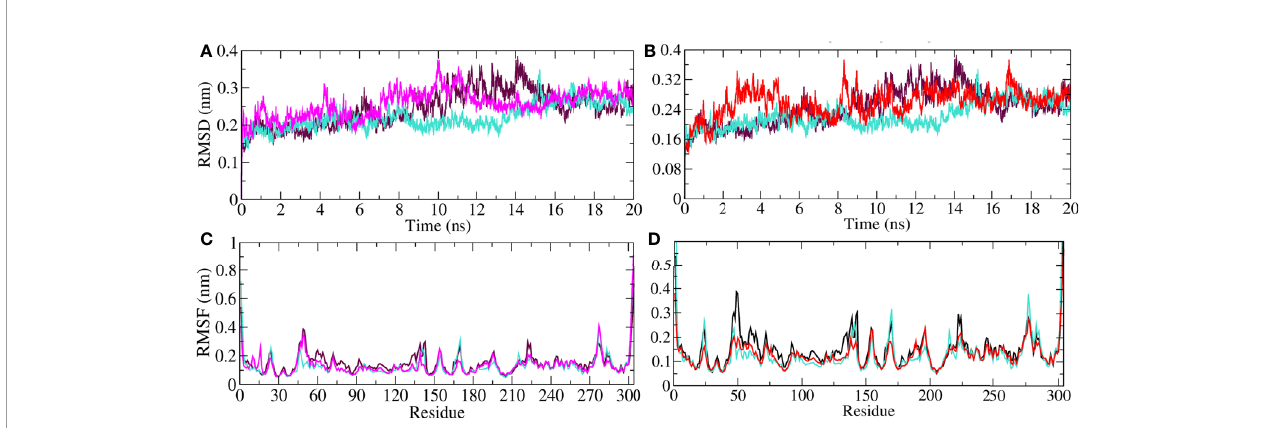
FIGURE 5 | MD simulation trajectory plot of SARS-CoV-2 main protease in unbound and standard inhibitor ligand/natural lead compound bound complex. (A) The RMSD of the M pro protein and lopinavir/10-Hydroxyaloin A lead compound complex during 20 ns MD simulation. (B) The RMSD of the M pro and lopinavir/ Isoquercetin lead compound complex during 20 ns MD simulation. (C) The RMSF values of M pro protein and lopinavir/10-Hydroxyaloin A lead compound complex during 20 ns MD simulation. (D) The RMSF values of M pro protein and lopinavir/Isoquercetin lead compound complex during 20 ns MD simulation Unbound protein, black color; Aloe vera – bound complex, pink; Neem-bound complex, red; and Lopinavir-bound complex is shown in light-blue